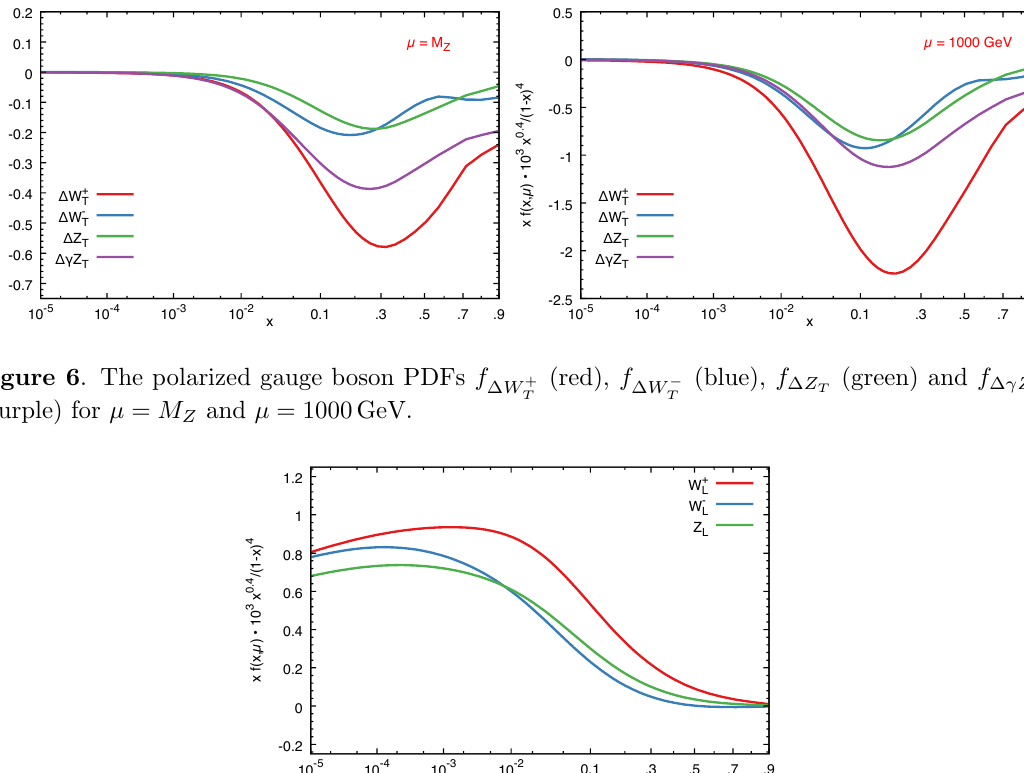
(red), f (blue), and f Z (green) for (cid:22) = M Z . W + L W (cid:0) L L